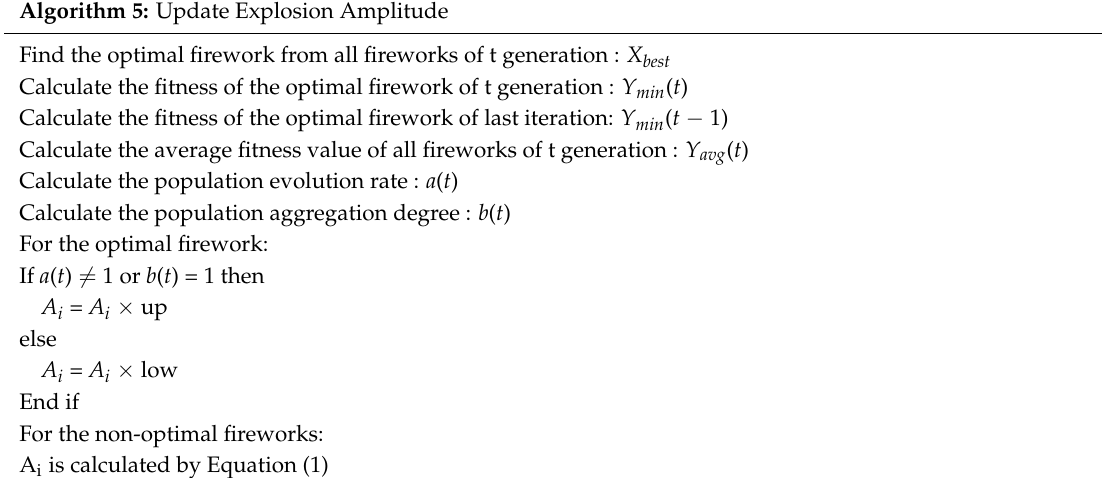
Algorithm 5: Update Explosion